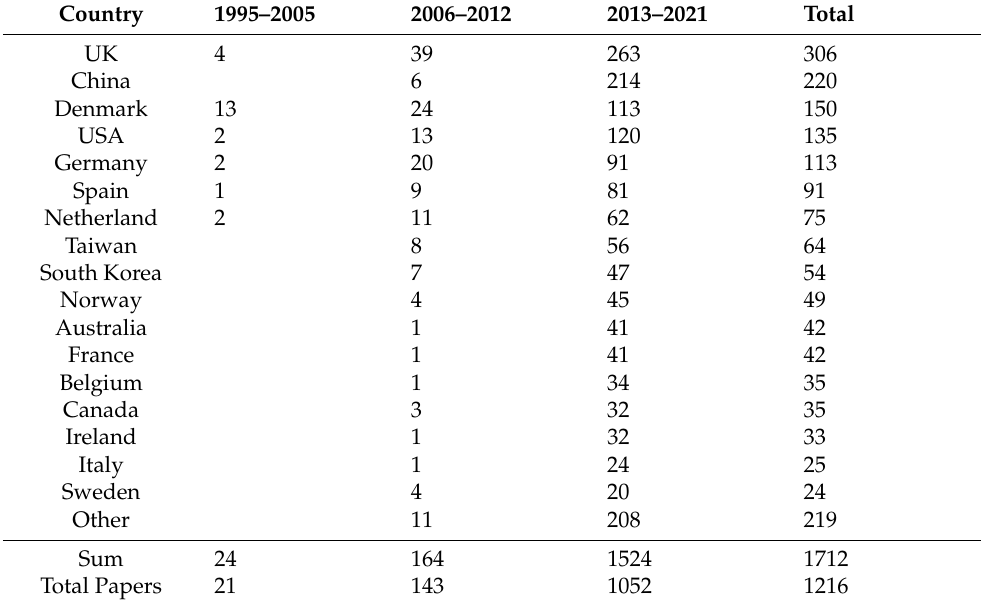
Table 1. The selected WOS papers related to offshore wind farm research by country during the three stages.